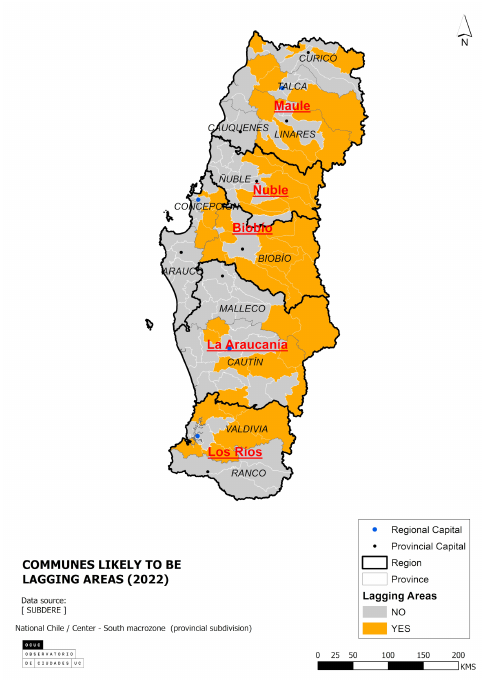
Figure 8: Lag zones by district and province of the south central macrozone of Chile